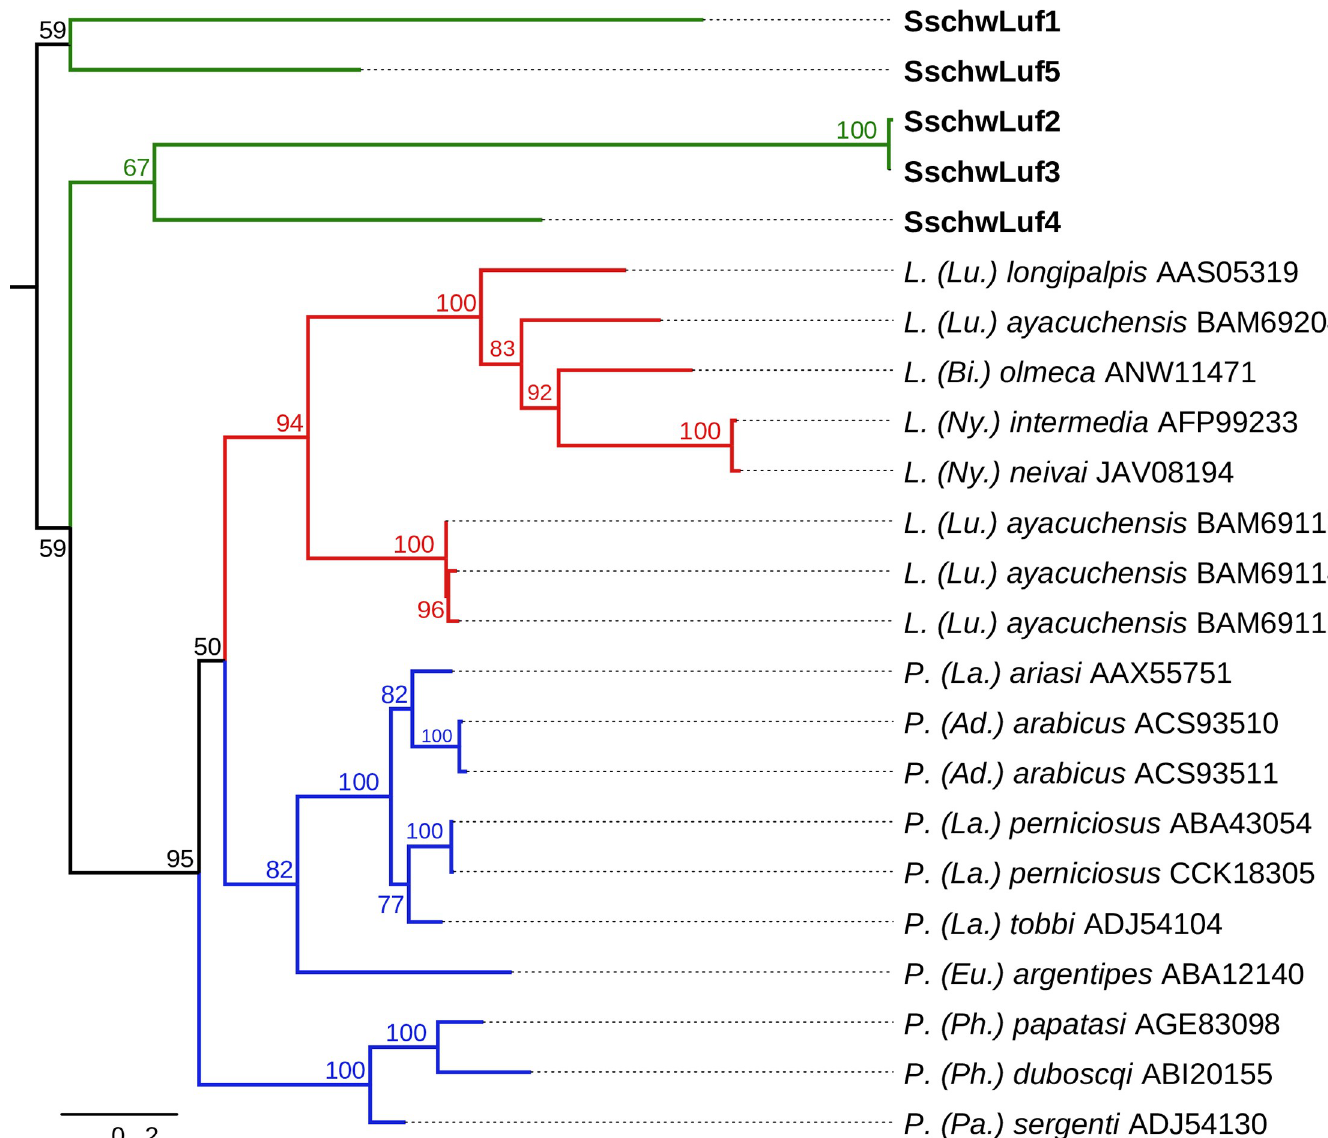
Fig 3. Phylogenetic comparison of lufaxin proteins. The phylogenetic tree with 23 sequences was based on MAFFT alignment with BMGE (threshold 0.5) containing 259 aa sites, 213 parsimony-informative sites, 18 singleton sites and 28 constant sites. The tree is unrooted. For more detail see Fig 2 legend.